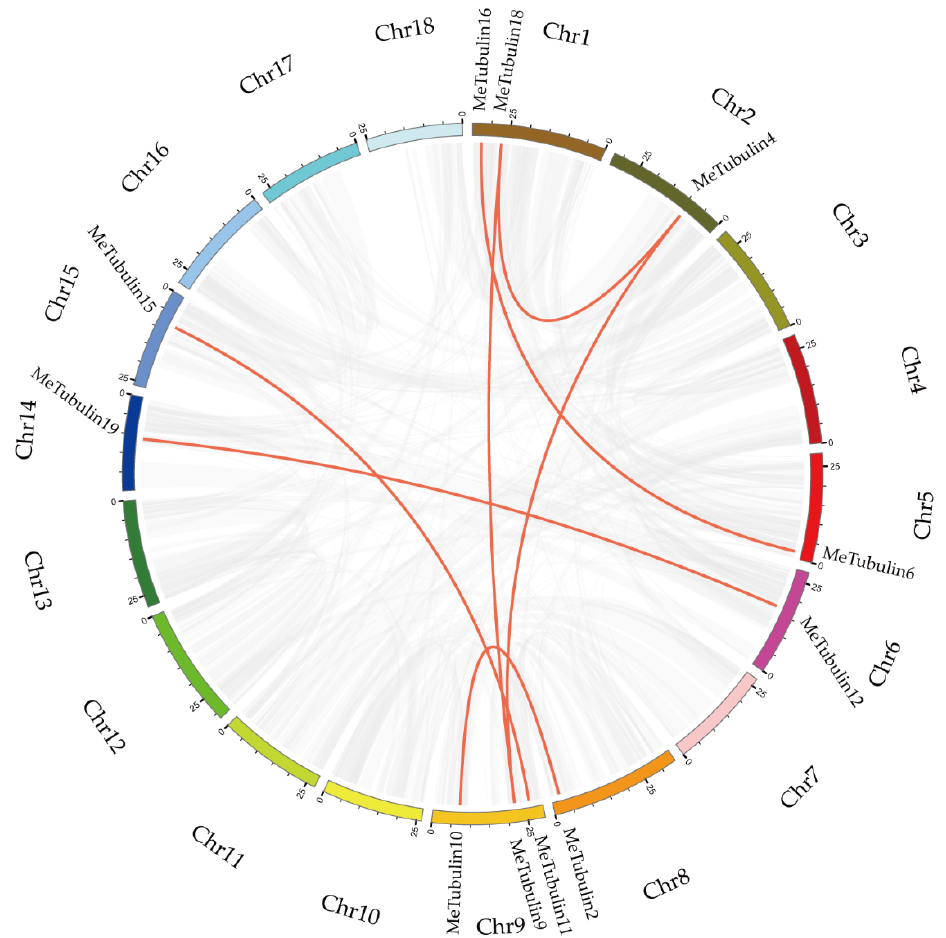
Figure 4. Schematic representations for the chromosomal distribution and inter-chromosomal relationships of MeTubulins . The synteny blocks in the cassava genome are represented by gray lines, and the duplicated tubulin gene pairs are by red lines. The bottom of each chromosome shows the chromosome number.